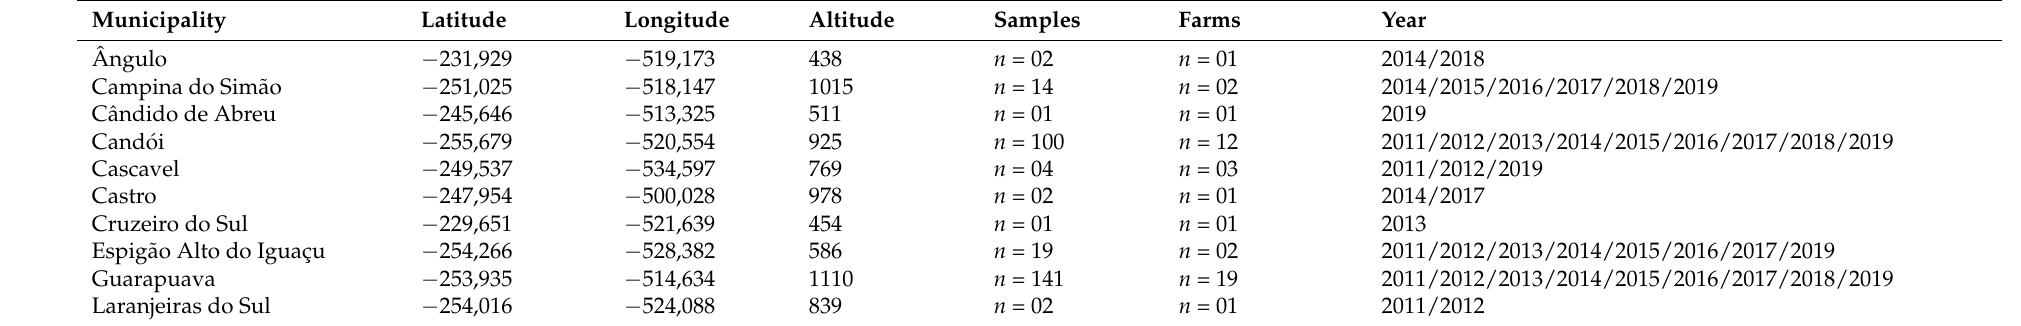
All municipalities belong to the CFA region: humid subtropical climate (Köppen). Table 2. Locations for collecting corn silage samples. Number ( n ) of samples and farms per site in 10 years of sampling.